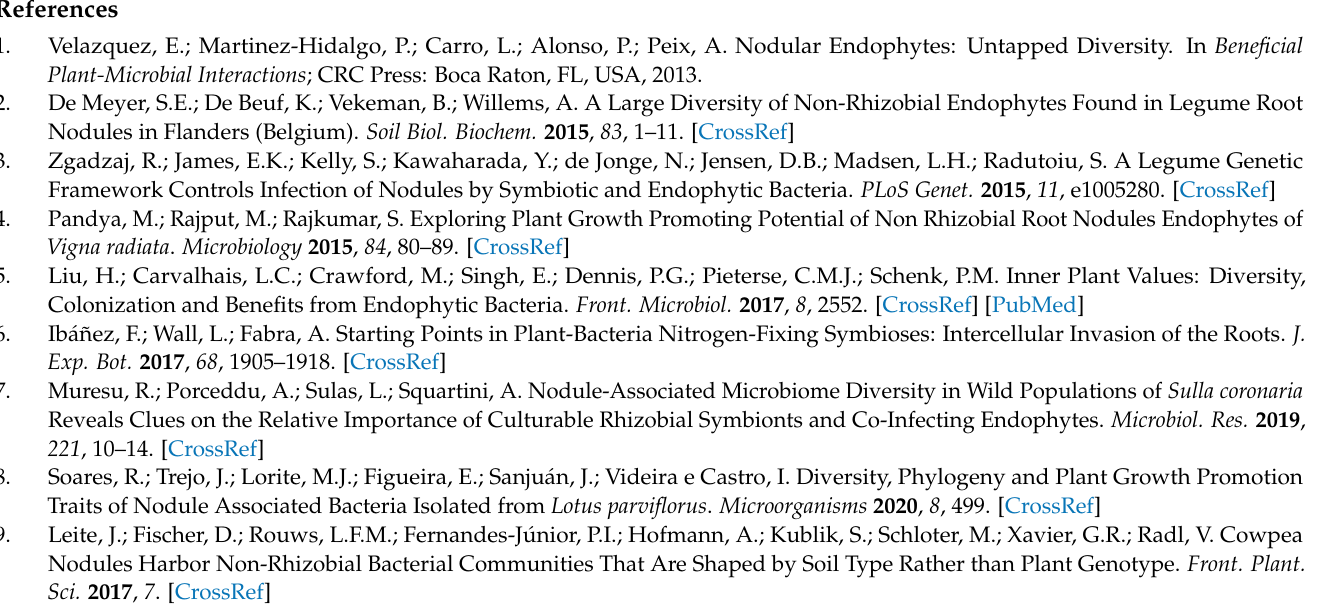
Table S2: Identified proteins in Sp2 ( Serratia plymuthica ); Table S3. Differential expression of proteins in Ra4 treated with 0.4% NaCl vs. Control; Table S4: Differential expression of proteins in Sp2 treated with 0.4% NaCl vs. Control; Table S5: GO terms of proteins overexpressed both in Ra4 and in Sp2 treated with 0.4% NaCl vs. Control. Table S6: GO terms of proteins overexpressed only in Ra4 treated with 0.4% NaCl vs. Control; Table S7: GO terms of proteins overexpressed only in Sp2 treated